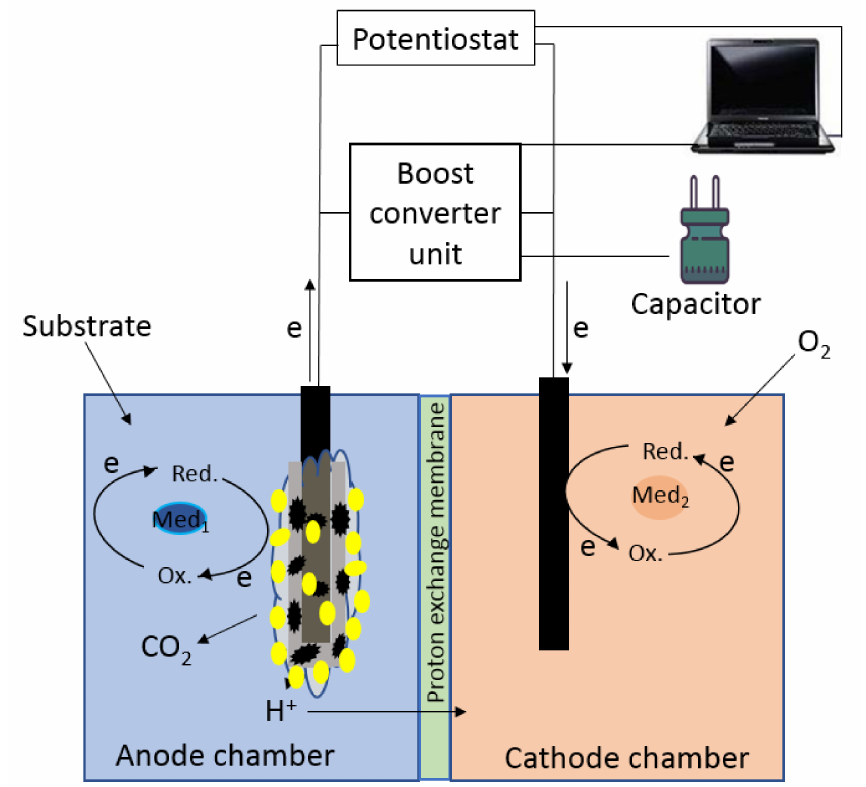
Figure 1. A schematic diagram of MFC operation and external